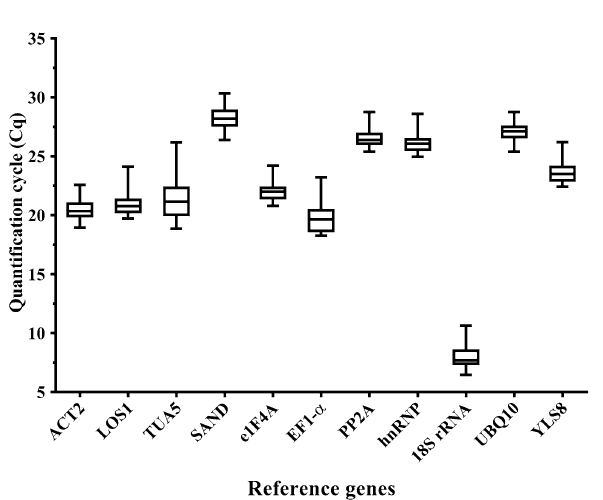
Figure 2. Cq values of 11 reference genes across all samples. The whiskers of the boxes are the maximum and minimum Ct values, and the horizontal lines inside the boxes represent the median of each reference